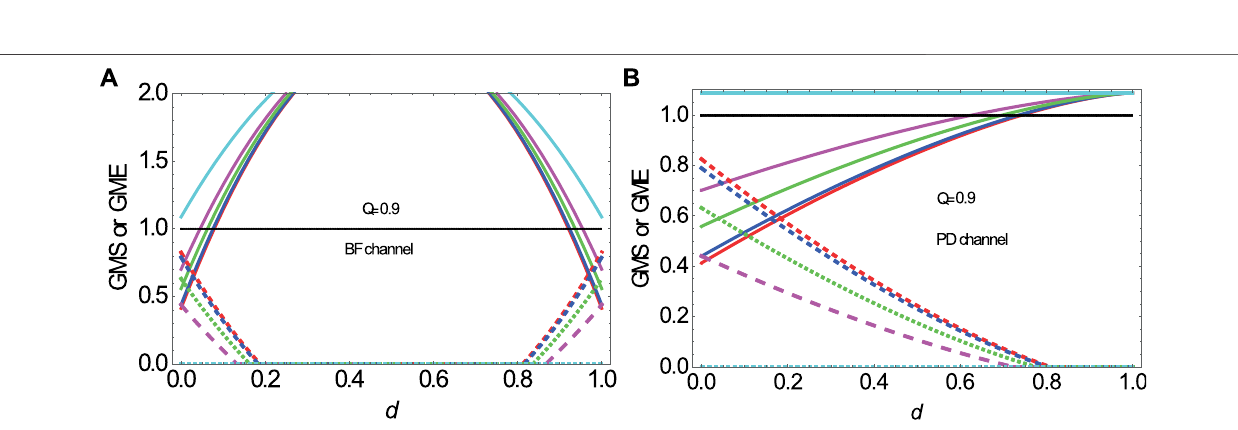
(cid:8)(cid:8) √ 2 /2 (red lines), α (cid:2) 0 . 3 (pink lines), α (cid:2) 0 . 6 (blue lines), α (cid:2) 0 . 9 (green